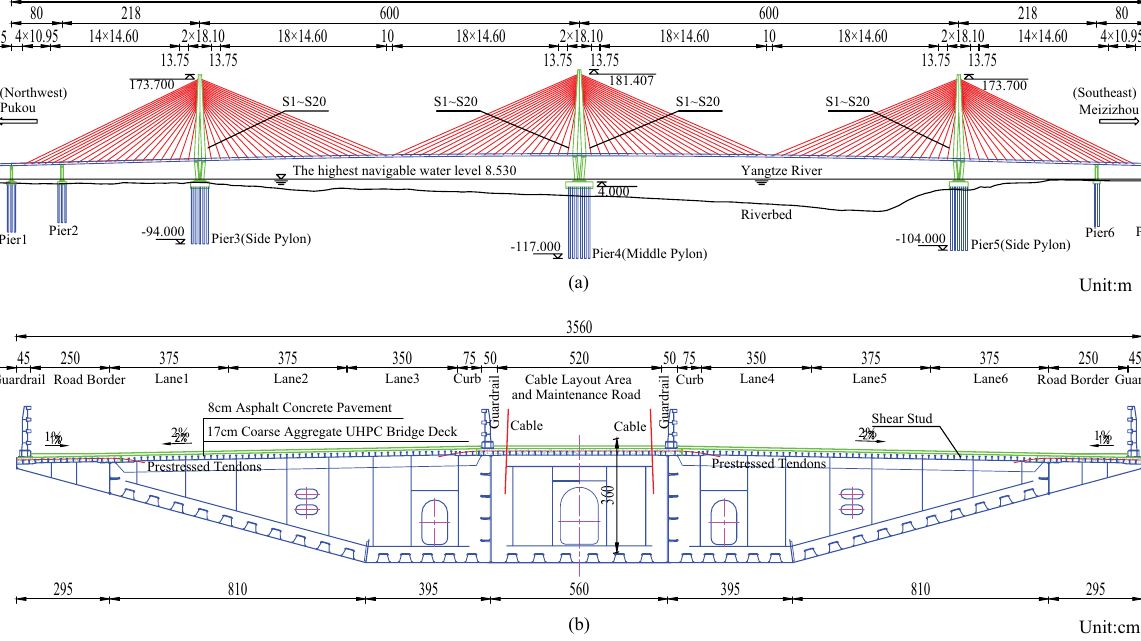
Figure 1. Overview of the Jiangxinzhou Yangtze River Bridge in Nanjing. ( a ) elevation view; ( b ) section of steel boxed girder.